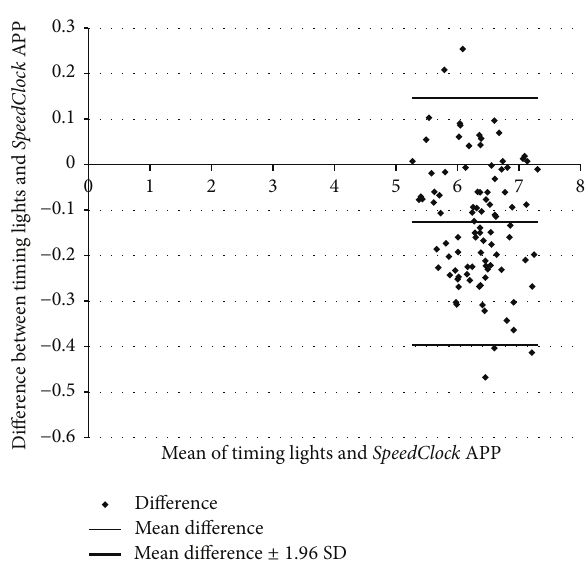
Figure 3: Bland-Altman plot depicting the level of agreement between timing lights and SpeedClock application for 10m